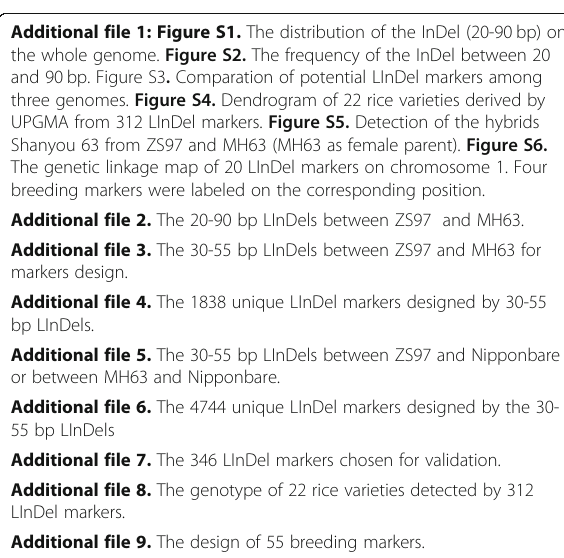
Additional file 9. The design of 55 breeding